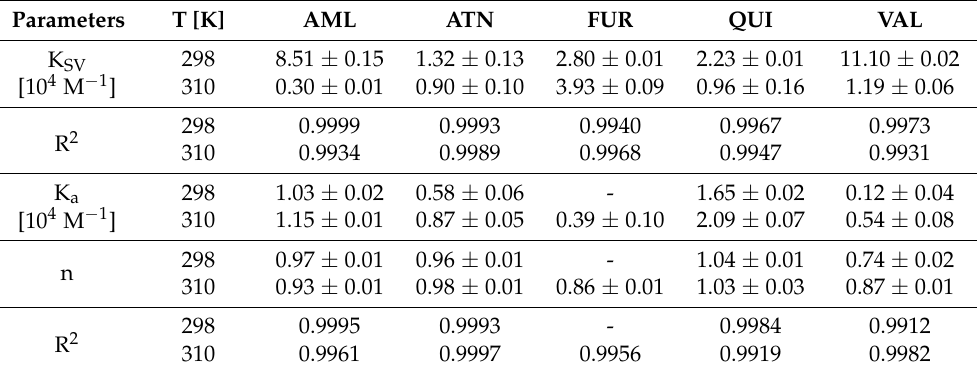
Table 1. The Stern–Volmer quenching constants (K SV ) and binding parameters (K a , the association constants; and n, the number of binding sites) of BSA–GLICL complex in presence of DRUG ligands (AML, ATN, FUR, QUI, VAL) at 298 and 310 K. Parameters T [K]